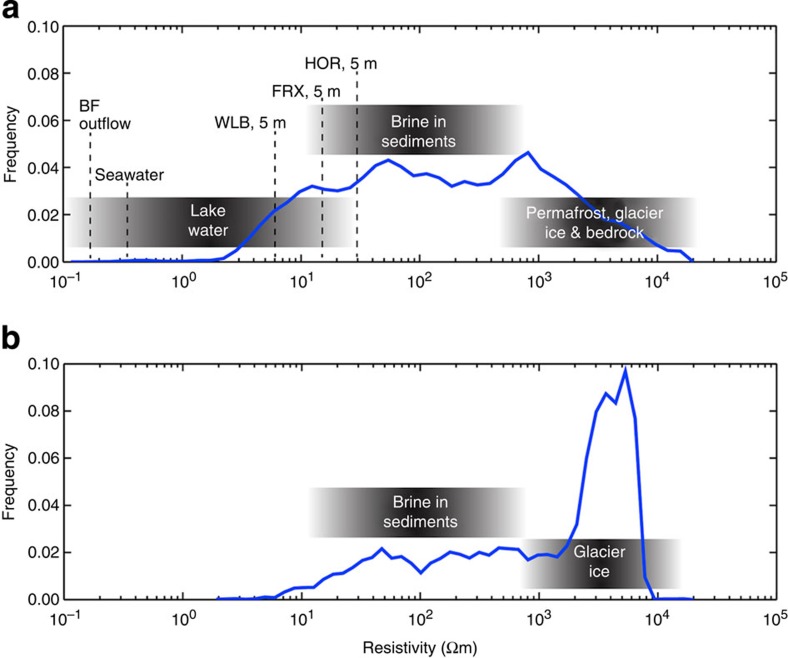
Resistivity histograms from Taylor Valley survey.Estimated resistivity ranges for lake water, brine in sediments and permafrost/glacier ice and bedrock are indicated. The two histograms were derived from the AEM data (a) Lower Taylor Valley in situ measurements marked: FRX, Lake Fryxell; HOR, Lake Hoare; WLB, West Lake Bonney (depth of measurement in metres follows abbreviation); BF, Blood Falls. (b) Histogram of data from Taylor Glacier with measurements from nearby Lake Bonney removed.